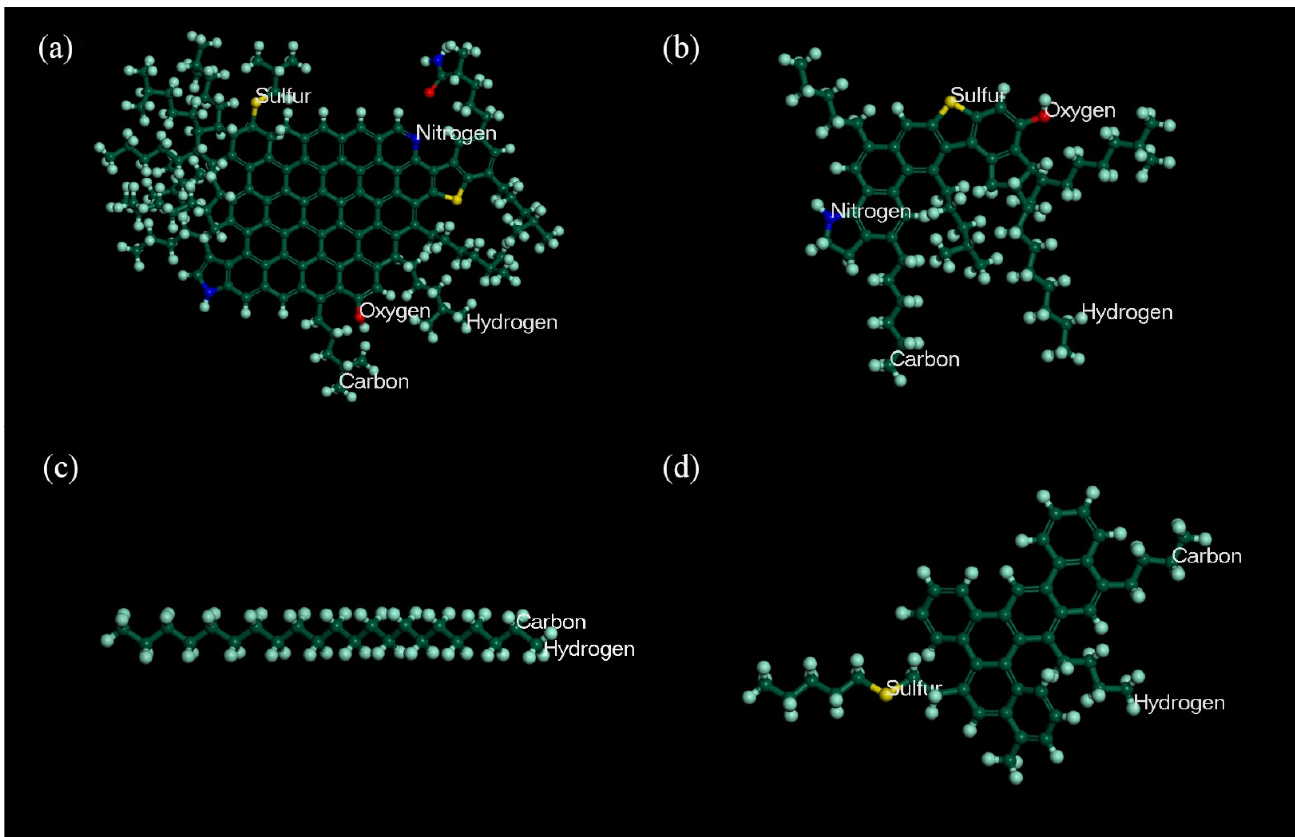
Figure 2. Models of representative molecules in bitumen. ( a ) asphaltene; ( b ) resin; ( c ) saturate; ( d ) aromatic. Table 1. Specific information about the asphalt model.